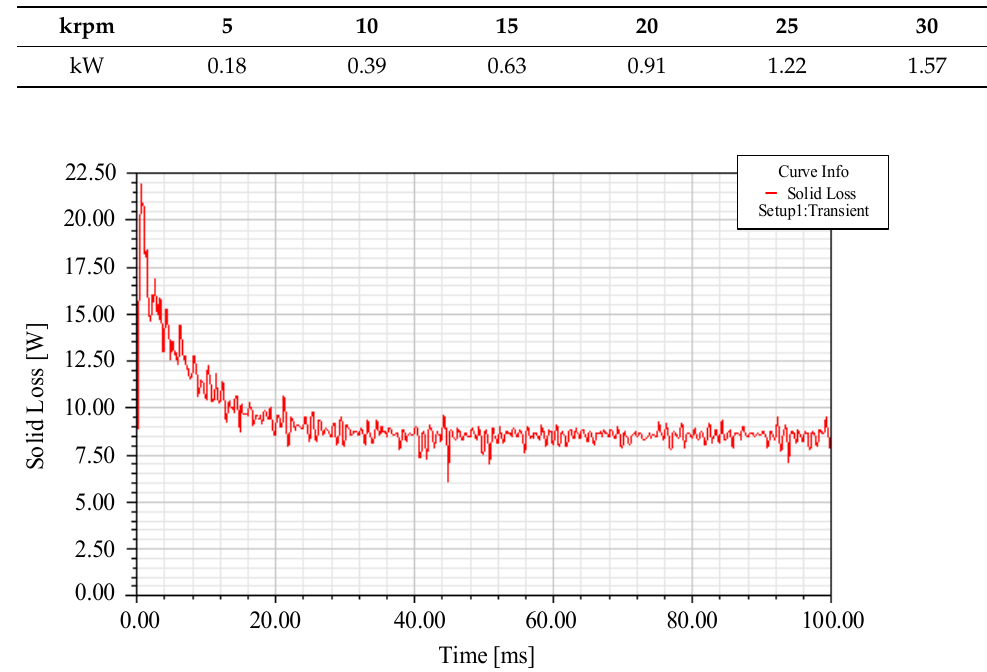
Figure 18. Rotor eddy current loss.